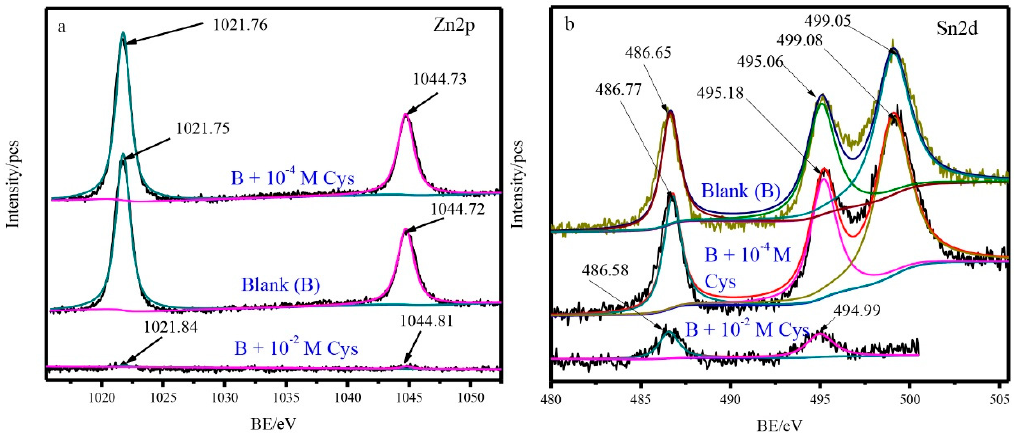
Figure 7. High-resolution XPS of Zn2p ( a ) and Sn3d ( b ) spectra of Cu5Zn5Al1Sn alloy surface without and with addition of inhibitors in 3.5 wt.% NaCl solution. Table 3. Composition (atomic %) of the surface of Cu5Zn5Al1Sn alloy samples before and after the addition of inhibitors in a 3.5 wt.% NaCl